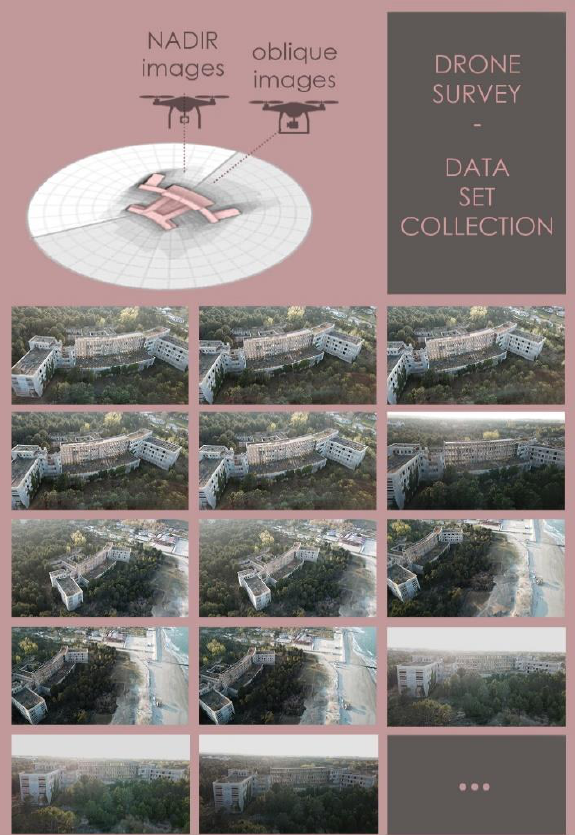
Figure 15. Drone survey - data set